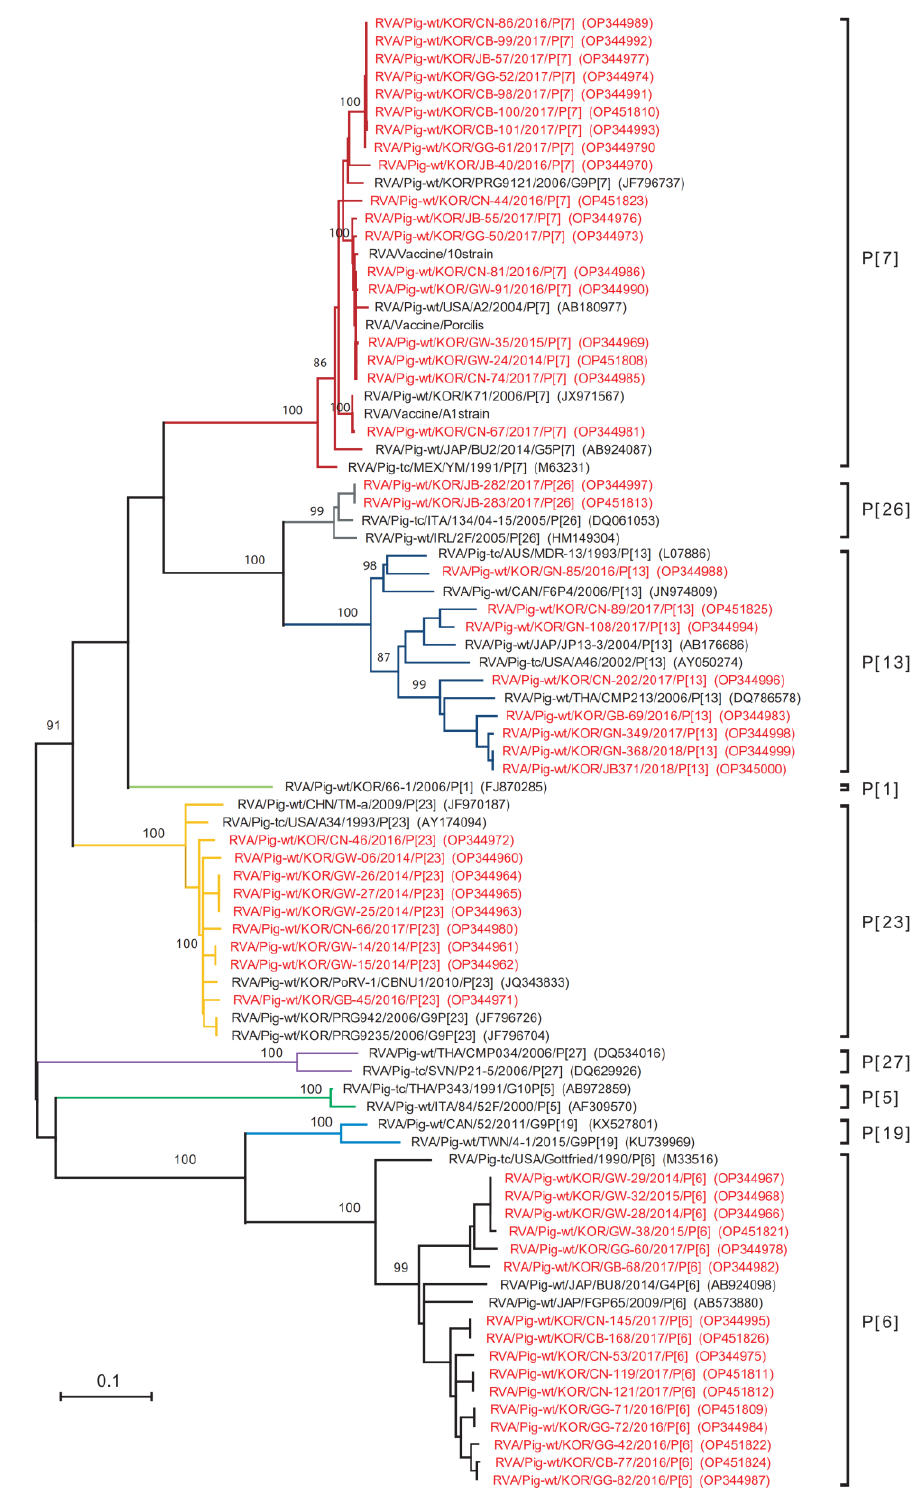
Figure 4. Phylogenetic analysis based on a partial nucleotide sequence of the VP4 gene from 53 PoRVA antigen-positive samples and selected reference strains. The phylogenetic tree was reconstructed based on the HKY (Hasegawa-Kishino-Yano) model in the MEGA X program, with 1000 bootstrap values. The 53 Korean PoRVA isolates identified in this study are denoted by red letters.